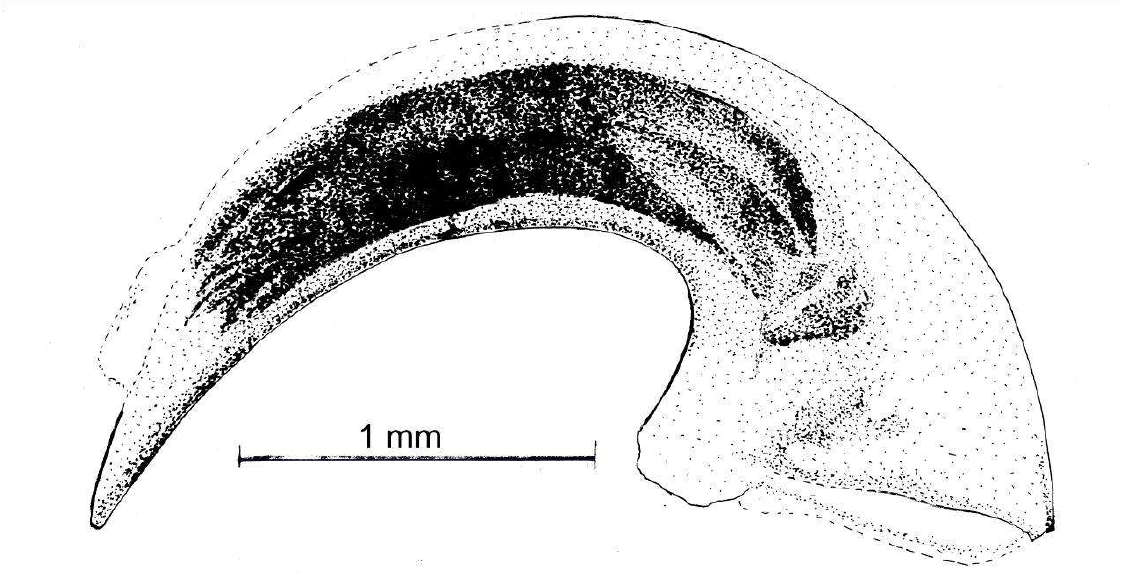
F IGURE 2. Median lobe of aedeagus, right lateral aspect. Scale: 1